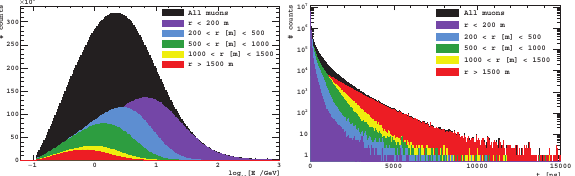
Figure 3. Energy spectra (left) and arrival time distribution (right) of muons arriving at the ground plane. We use the same notation for the two plots: black – all muons; violet – r < 200 m; blue – 200 < r [ m ] < 500; green – 500 < r [ m ] < 1000, yellow – 1000 < r [ m ] < 1500, and red – r > 1500 m.